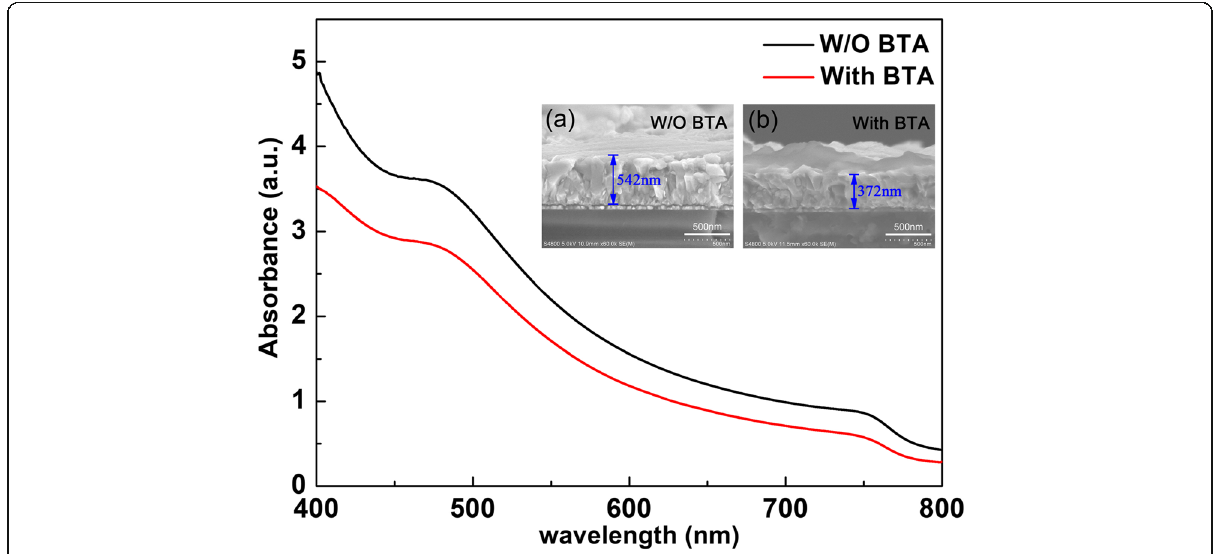
Fig. 5 UV-Vis absorption spectrum of MAPbI 3 films on quartz substrates with and without BTA additive. Insets are cross-section SEM images of